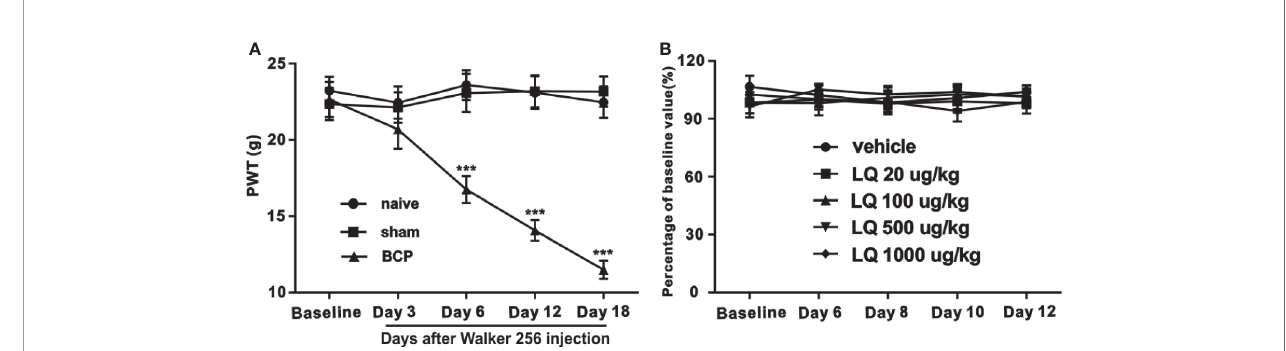
FIGURE 2 | Mechanical allodynia induced by bone cancer and the effects of intrathecally administered Liquiritin (LQ) on motor performance of naïve rats in rotarod test. After operation, the mechanical pain domain has no obvious change in sham group. In contrast, in bone cancer pain (BCP) group, paw withdrawal thresholds (PWT) began to decrease on day 6 until day 18 (F 2,21 = 22.94, ***P < 0.001 vs. control; n = 8, two way ANOVA, 2A ). Compared with baseline response, intrathecal injection of Liquiritin (LQ) (20, 100, 500, and 1,000 ug/kg) for 7 days did not affect the motor performance (F 4,35 = 0.5979, P > 0.05 vs. control; n = 8, two way ANOVA, 2B ). The results were expressed as percentage of each rat ’ s own baseline